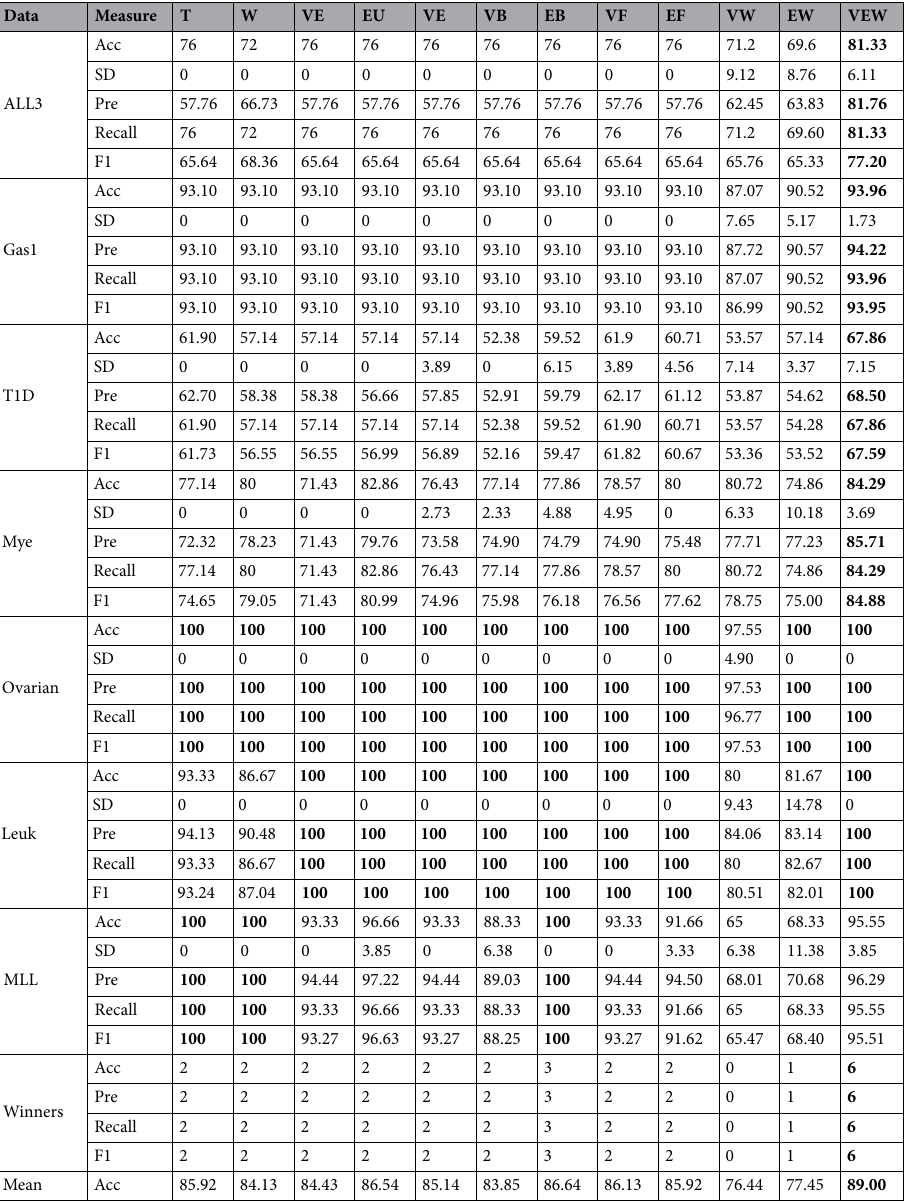
Table 2. Performance comparison of algorithms on classifier